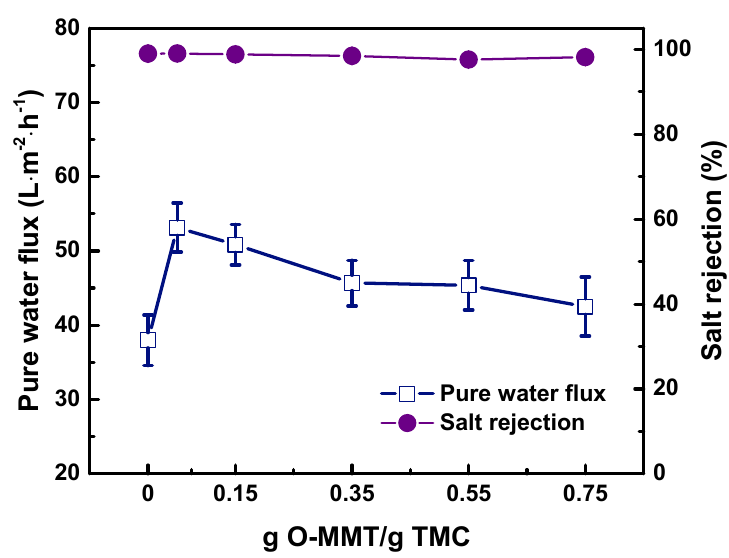
Figure 11. Nanofiltration performance of TFN O-MMT membrane at varying weight ratio of O-MMT and TMC. Feed = 1000 ppm Na 2 SO 4 solution; Operating condition: pH = 7, 6 bar, 30 °C.